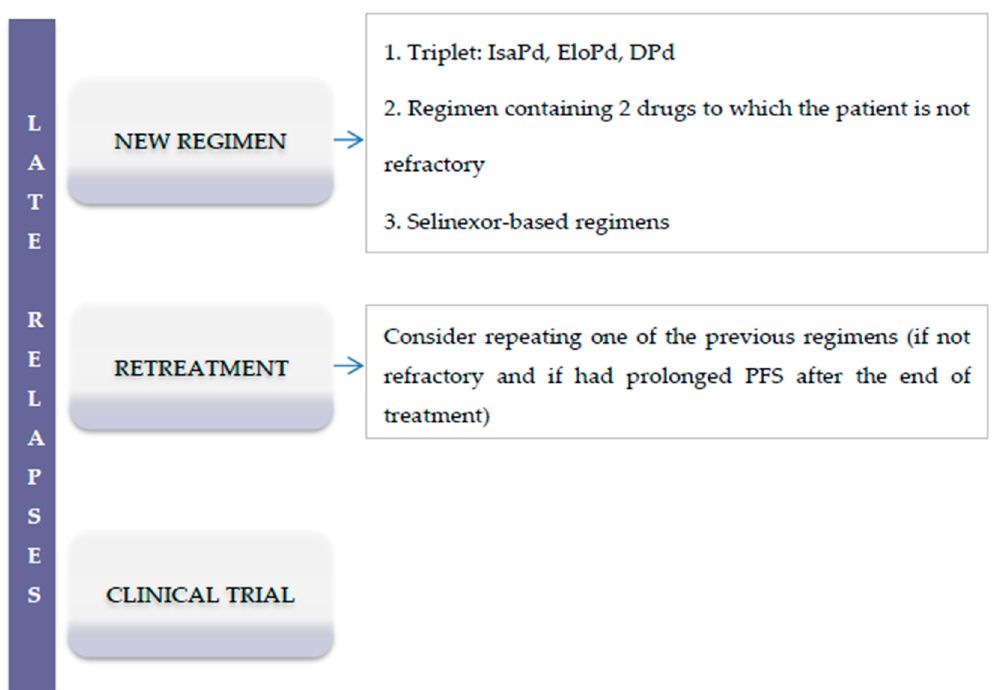
Figure 3. Suggested treatment options for RRMM patients in advanced phases of the disease (>3 lines of therapy). Abbreviations: IsaPd: Isatuximab, pomalidomide, dexamethasone; EloPd: Elotuzumab, pomalidomide, dexamethasone; DPd: Daratumumab, pomalidomide, dexamethasone; PFS, progression-free survival.